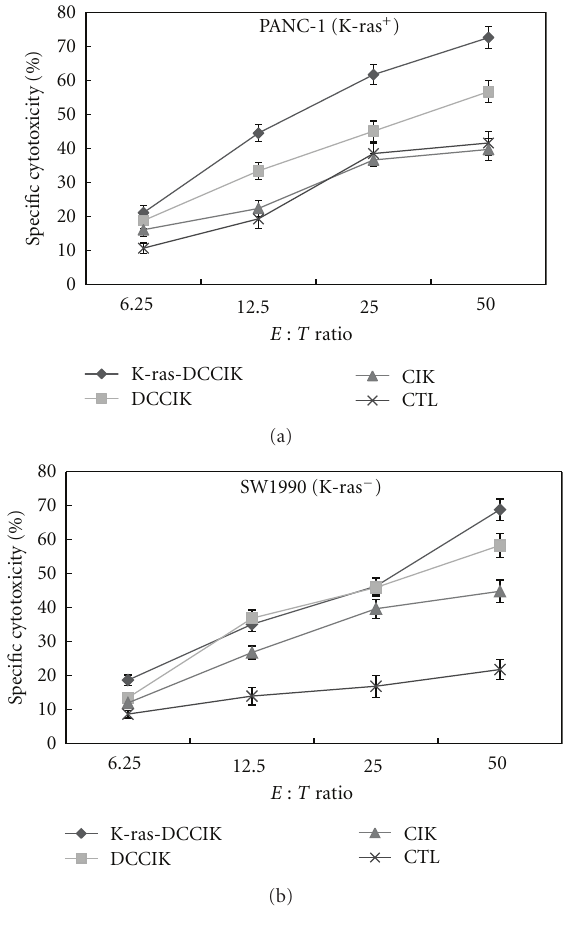
Figure 6: The cytotoxicity of K-ras-DCCIK, DCCIK, CIK, and CTL induced by K-ras pulsed DC against PANC-1 (K-ras + ) and SW1990 (K-ras − ) cells in vitro (experiment 2.7). The K-ras- DCCIKs, DCCIKs, CIKs, and CTLs induced by K-ras pulsed DCs used as e ff ector cells. PANC-1 and SW1990 used as target cells. The killing e ff ects on PANC-1 showed that group K-ras-DCCIK exceed- ed group CIK and group CTL remarkably ( P < 0 . 01). However, there was no di ff erence between group CIK and CTL ( P > 0 . 05),